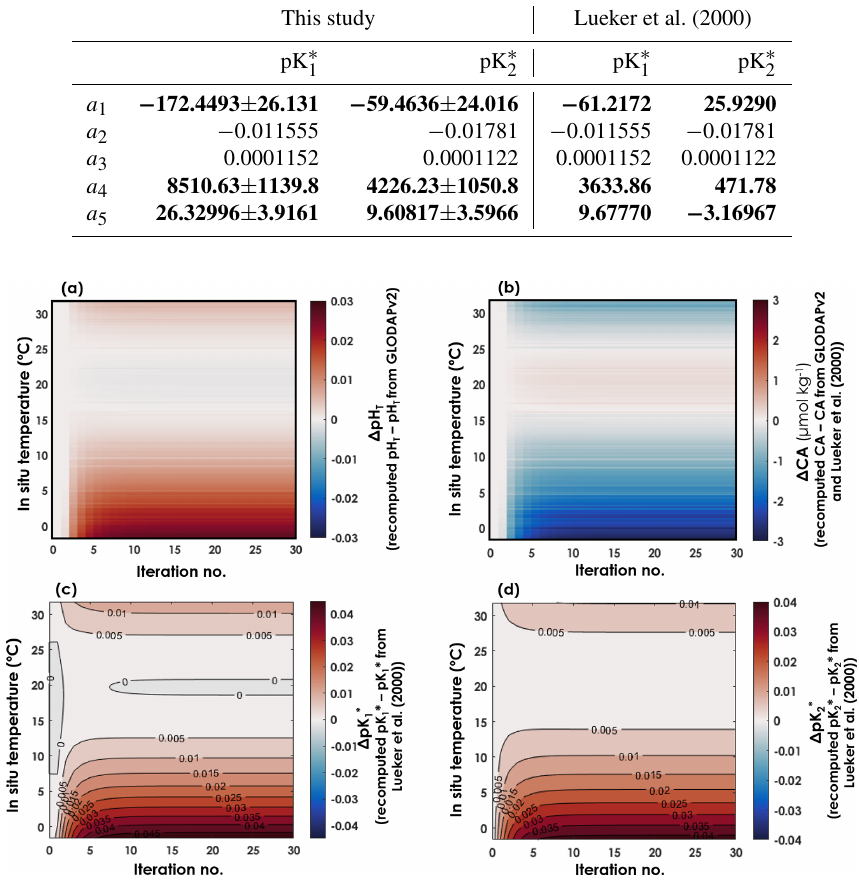
Figure 2. Evolution of pH T , CA, pK ∗ and pH T from GLODAPv2. (b) Differences between recomputed CA and CA estimated from GLODAPv2 data and the Lueker et al. (2000) constants. Differences between recomputed (c) pK ∗ salinity of